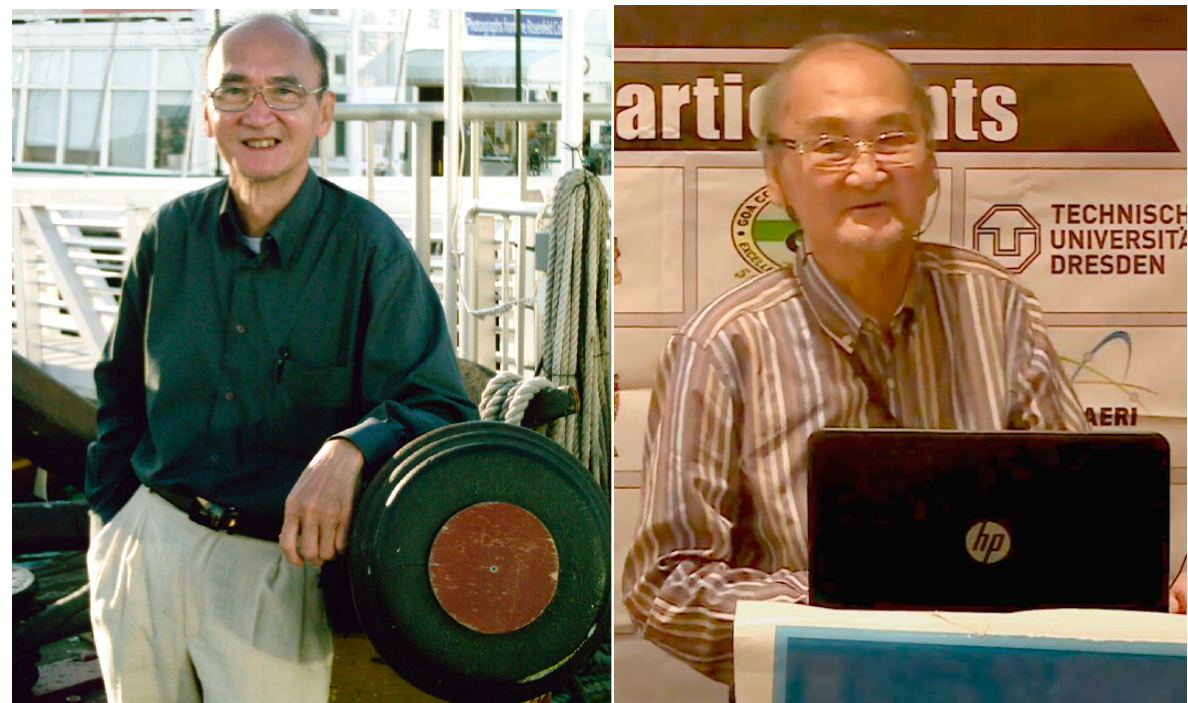
Figure 2. Gaston Hui Bon Hoa at Scientific Meetings. Left: A photo taken during the Fifth International Conference on High-Pressure Biosciences and Biotechnology (San Diego, CA, USA, September 2008). Right: Gaston presents his talk at the 7th Asia-Pacific Biotech Congress (Beijing, China, July 2015, Available online: https://www.youtube.com/watch?v=-4vs2mvqSGs (accessed on 18 July 2021)).